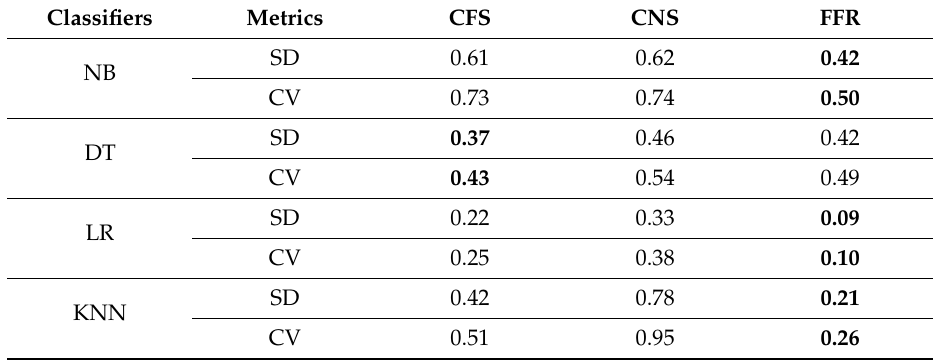
Table A1. Performance Stability of FS methods on Prediction Models based on Average Accuracy Values.